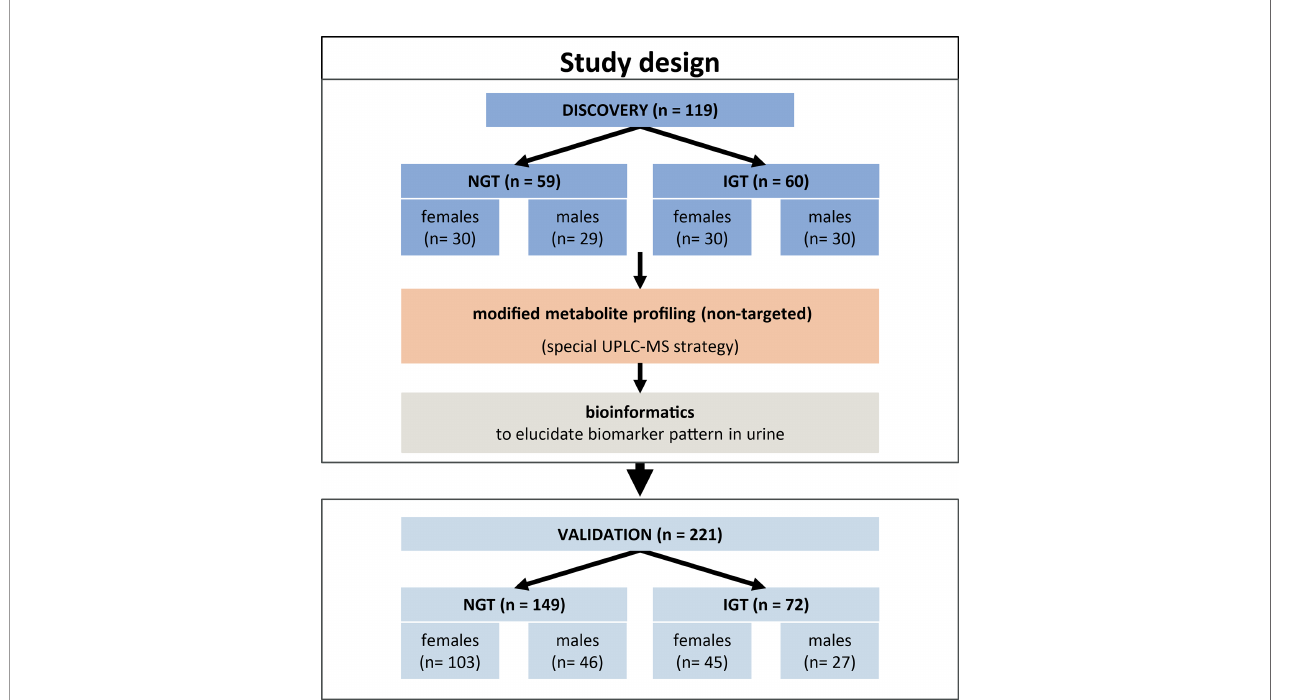
FIGURE 1 | Overview of the study design and cohorts for the discovery and validation of a diagnostic pattern in second morning urine for prediabetes screening.